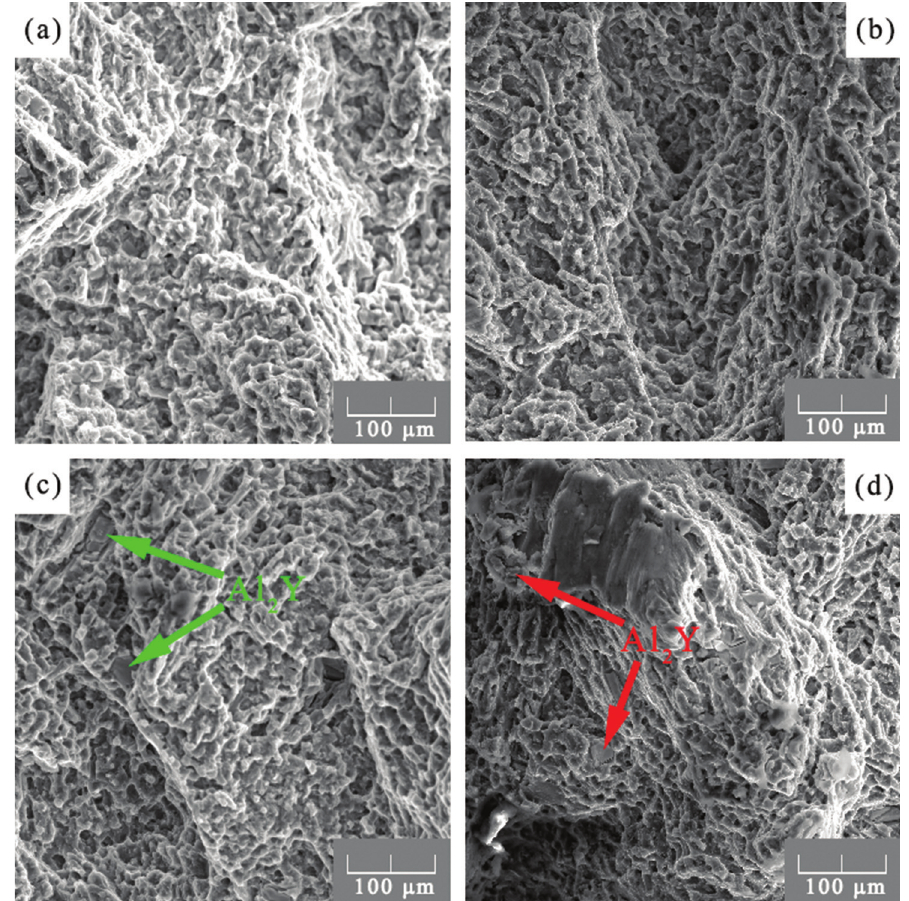
Figure 7: The SEM images of the tensile fracture morphology of the investigated alloys: (a) alloy 1; (b) alloy 2; (c) alloy 3; (d) alloy